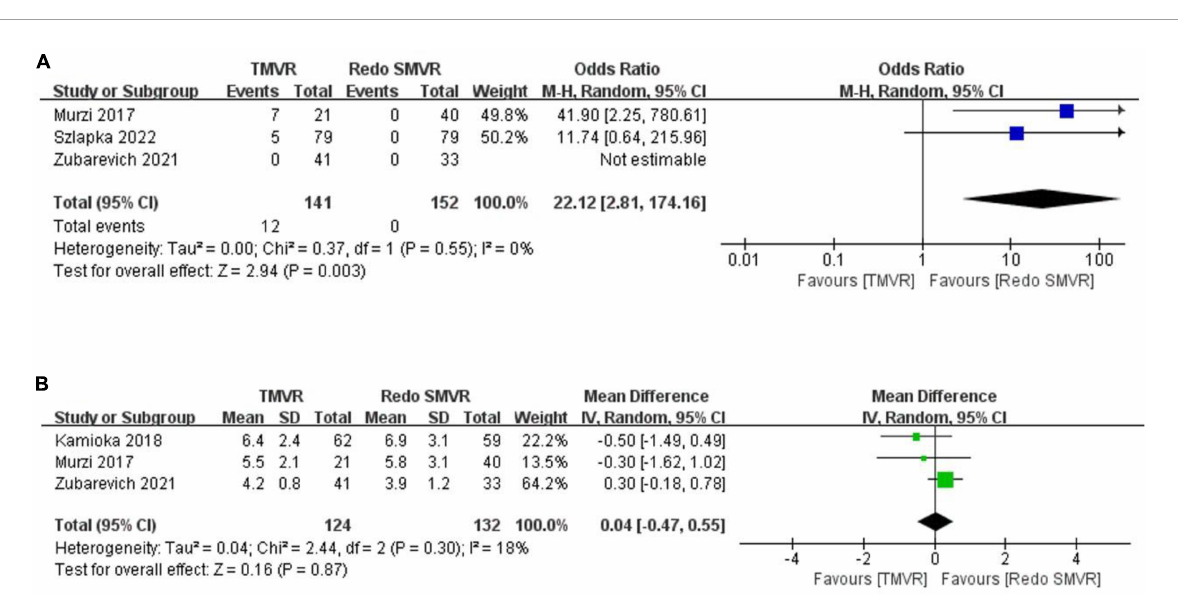
redo SMVR and TMVR therapy have been reported (5, 18). However, comparisons between redo SMVR and TMVR are limited. Therefore, we performed a meta-analysis to assess the outcomes of redo SMVR and TMVR for patients with mitral prosthesis